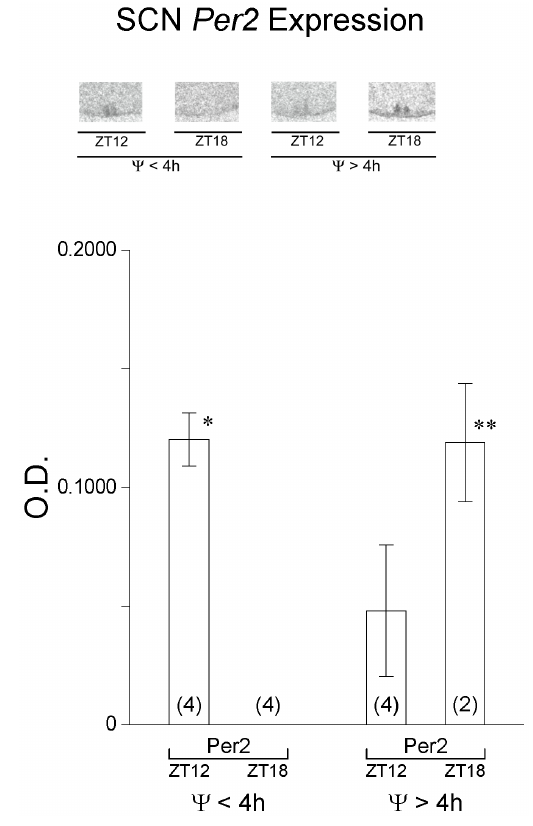
Figure 10. Clock gene expression in the suprachiasmatic nucleus. (top) Representative autoradiogram images of per2 expres- sion in the suprachiasmatic nucleus (SCN) measured by in situ hybridization for animals in 8L:14D entrained with Y s # 4 h delayed and Y s . 4 h delayed and killed at ZT 12 and ZT 18. Quantification shows that Per2 expression is significantly greater at ZT 12 vs ZT18 in animals with Y s # 4 h delayed whereas in animals with Y s . 4 h delayed, per2 expression is significantly greater at ZT18 vs ZT12 indicating that the SCN clock gene rhythms are in different phases in these two populations of animals relative to light offset.